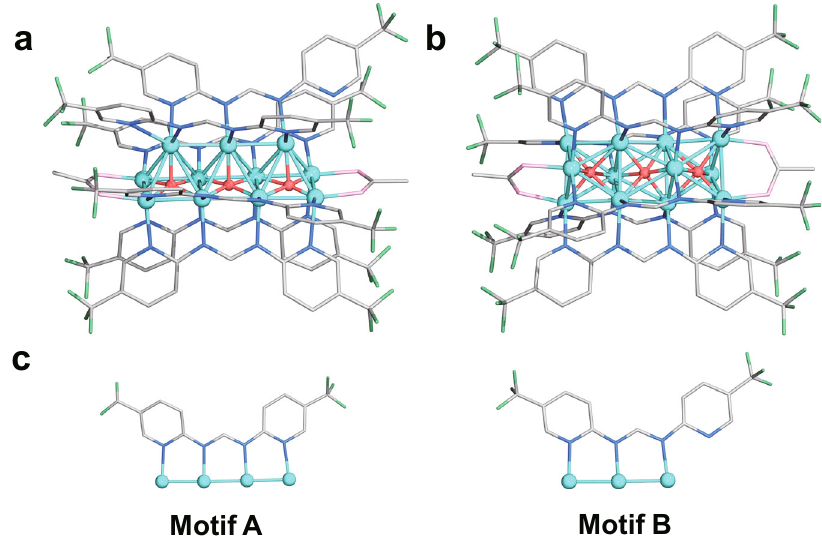
Fig. 3 Molecular structures of Cu 11 and Cu 12 . Total structure of Cu 11 H 3 (Tf-dpf) 6 (OAc) 2 ( a ) and [Cu 12 H 3 (Tf-dpf) 6 (OAc) 2 ] + ( b ). Schematic representation of the binding modes of Tf-dpf in Cu 11 and Cu 12 ( c ). Color legend: light blue, Cu; green, F; blue, N; pink, O; gray, C; red,